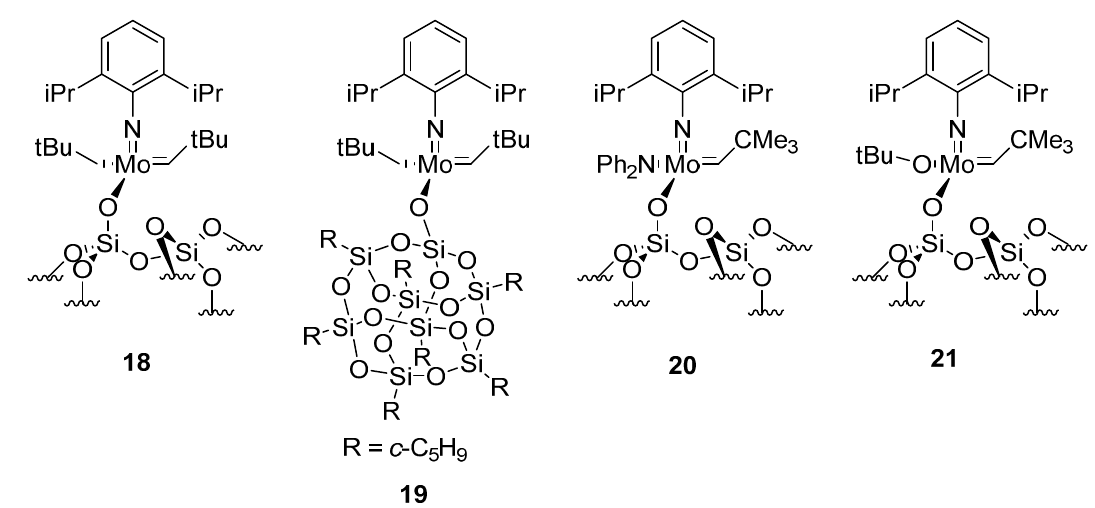
Figure 4. Examples of silica-supported olefin metathesis catalysts 18 – 21